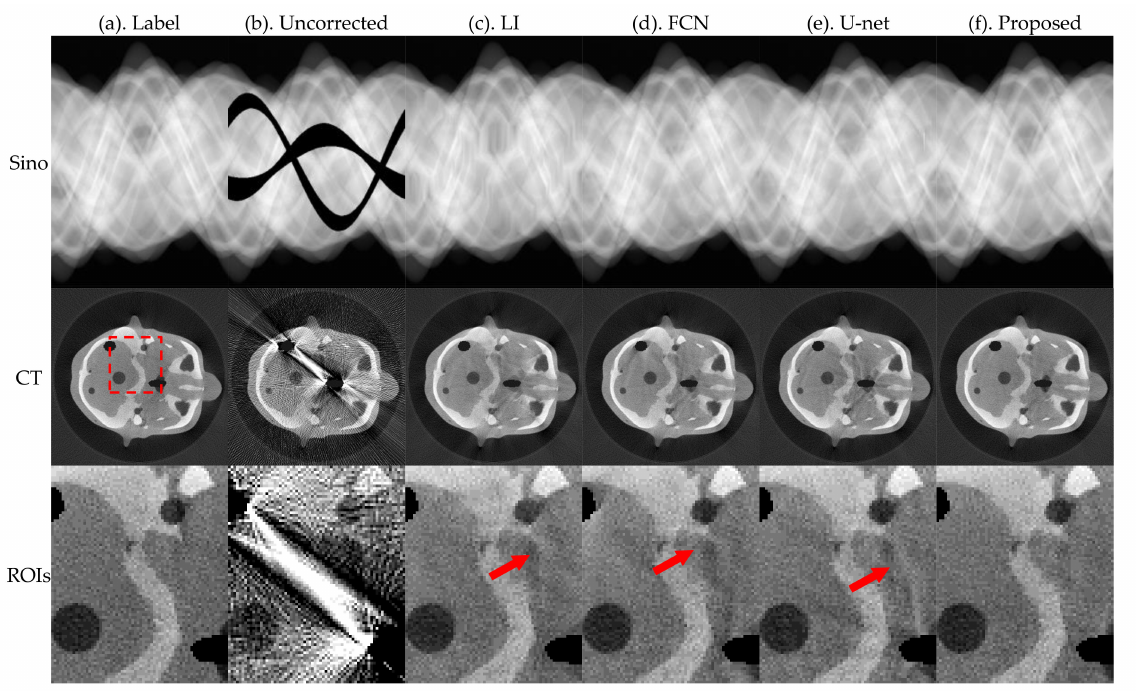
Figure 9. Results of head phantom, where the first row is the sinogram, the second row is the FBP-reconstructed results, and the third row is an enlarged view of the ROIs. The display window of sinogram is (0, 1). The display window of CT and ROIs is ( − 0.01,